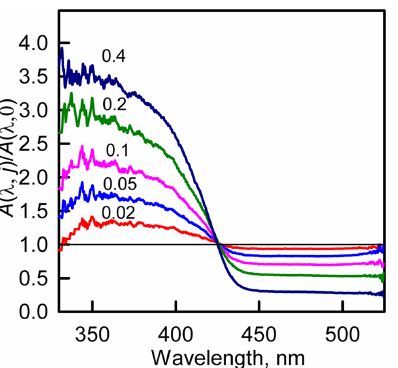
Figure 6. Molar absorption spectra of neutral (pink), anionic (red) and complexed with Cl 2 (green) states of sfGFP. Spectra decomposition was made on the basis of absorption spectra of sfGFP in the presence of studied agents. For details see the discussion section.